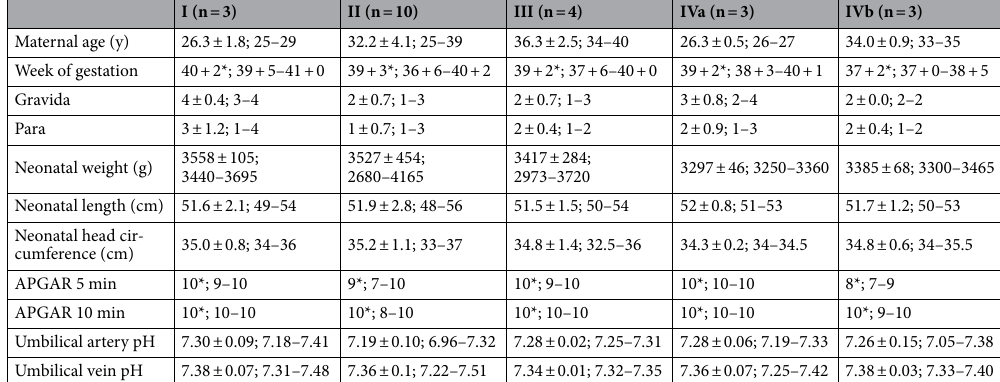
Table 2. Participant characteristics (n = 23 1 ) for mothers and term newborns (mean ± SD; min–max; *mean only). 1 One case was excluded from statistical analysis, because of preterm birth (34 + 3